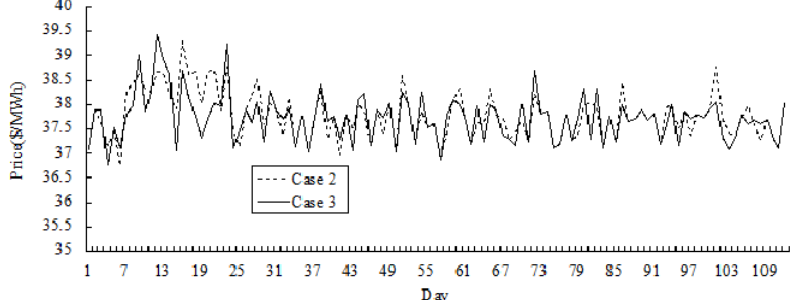
Figure 5. Comparative results of price variation for Cases 2 and 3 (for 112 days).